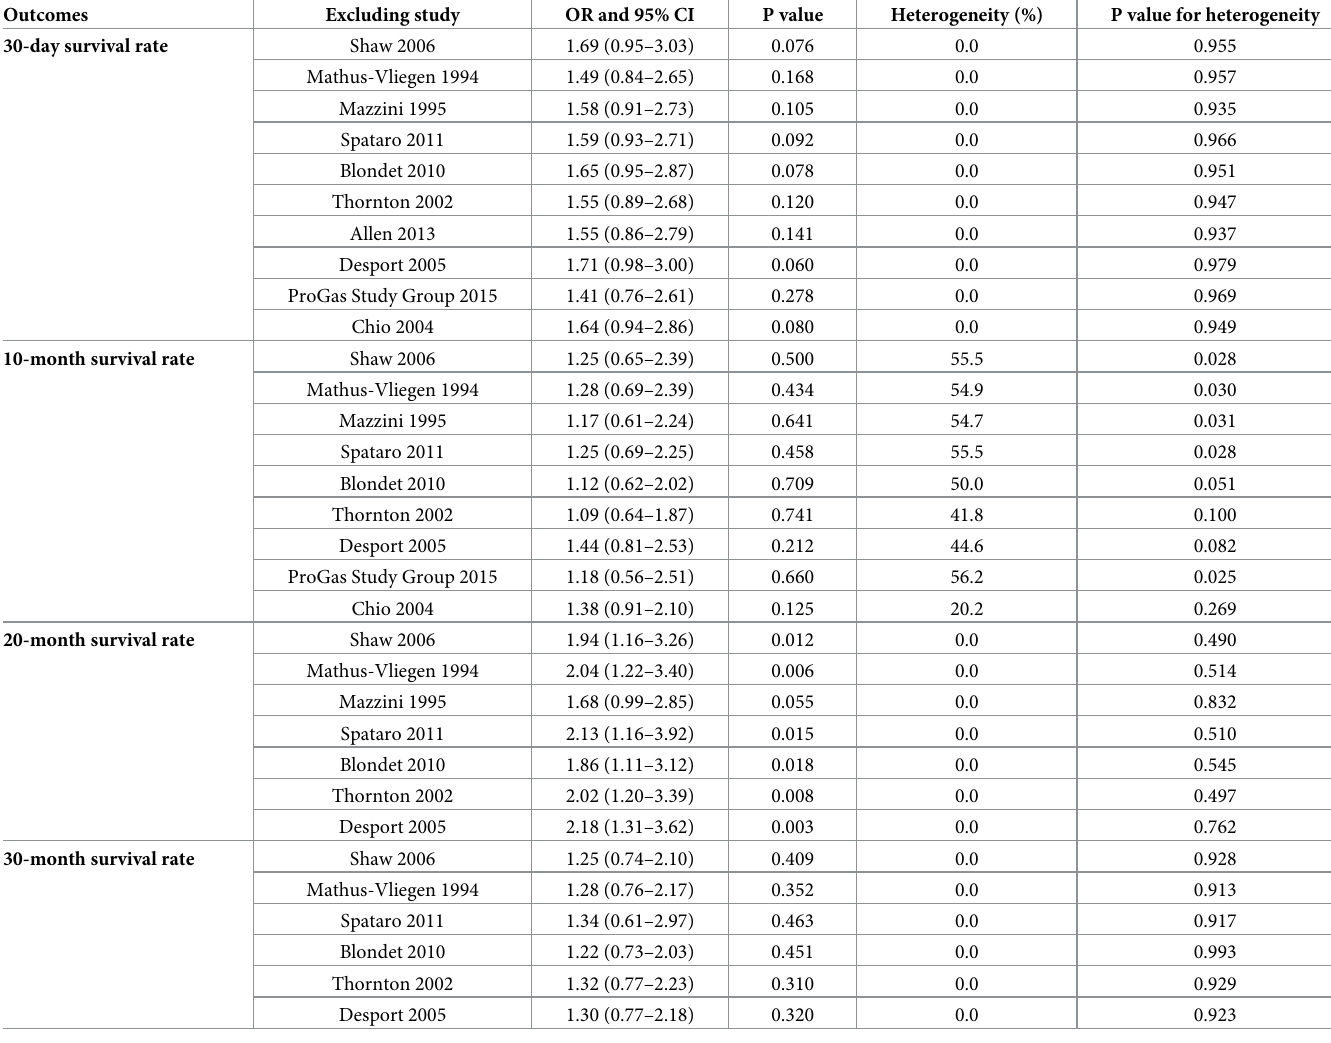
Table 2. Sensitivity